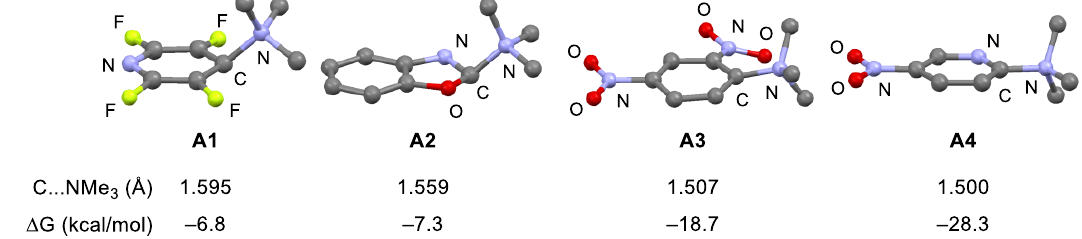
Figure 1. Calculated structures of complexes A formed upon interaction of aryl radicals with NMe 3 (UM06-2X/6-31+G(d), DMSO as solvent). Hydrogen atoms are omitted. Bond length between the carbon atom of the aromatic ring and the nitrogen and free energies of complex formation are shown.